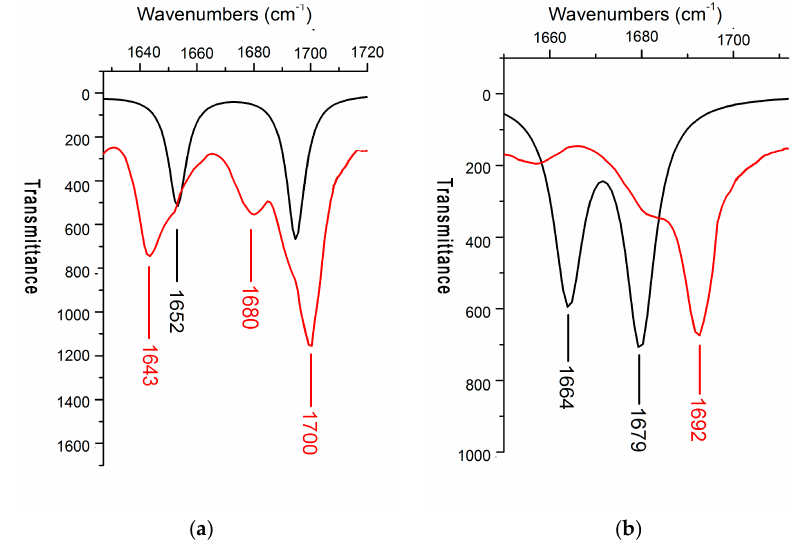
Figure 6. Experimental (red line) and calculated (black line) IR spectra showing carbonyl bands